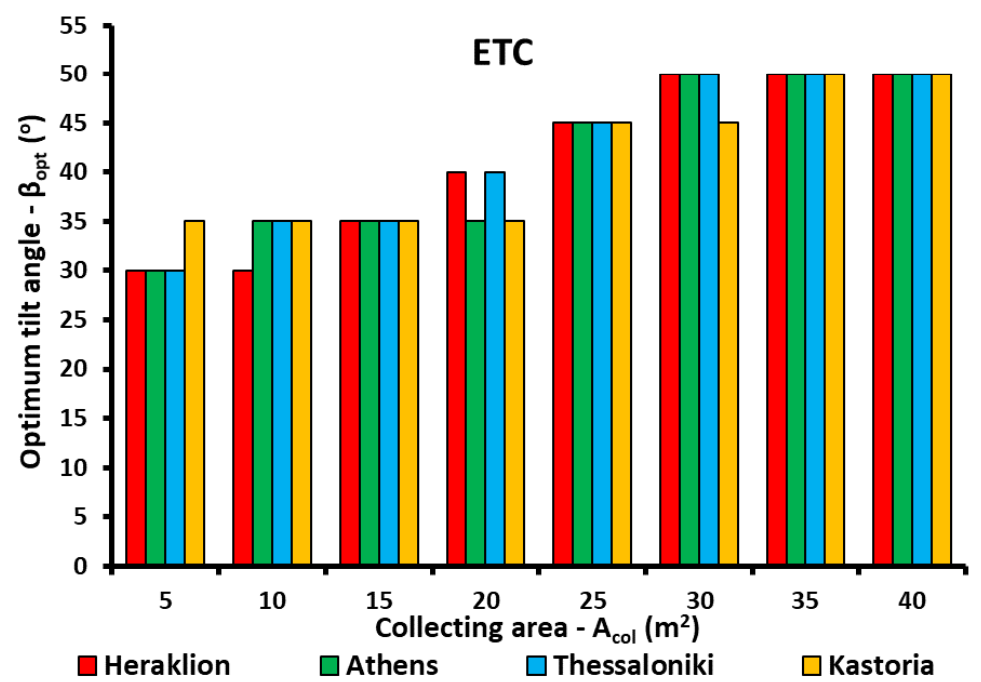
Figure 15. Optimum tilt angles for maximizing the solar coverage with ETC for the examined locations.